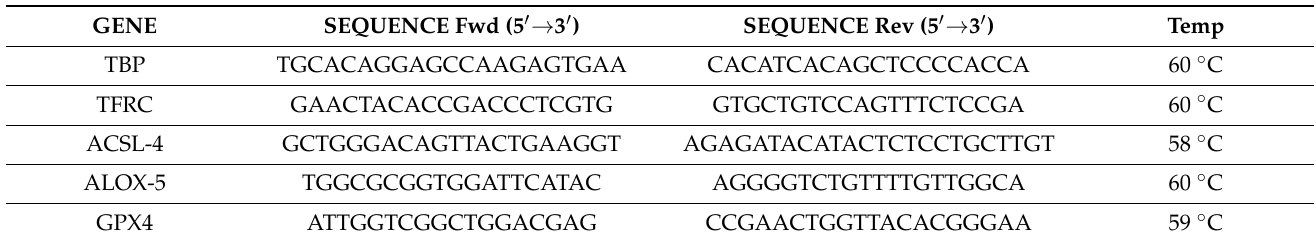
Table 3. Primers used for RT-qPCR: sequences and binding temperatures